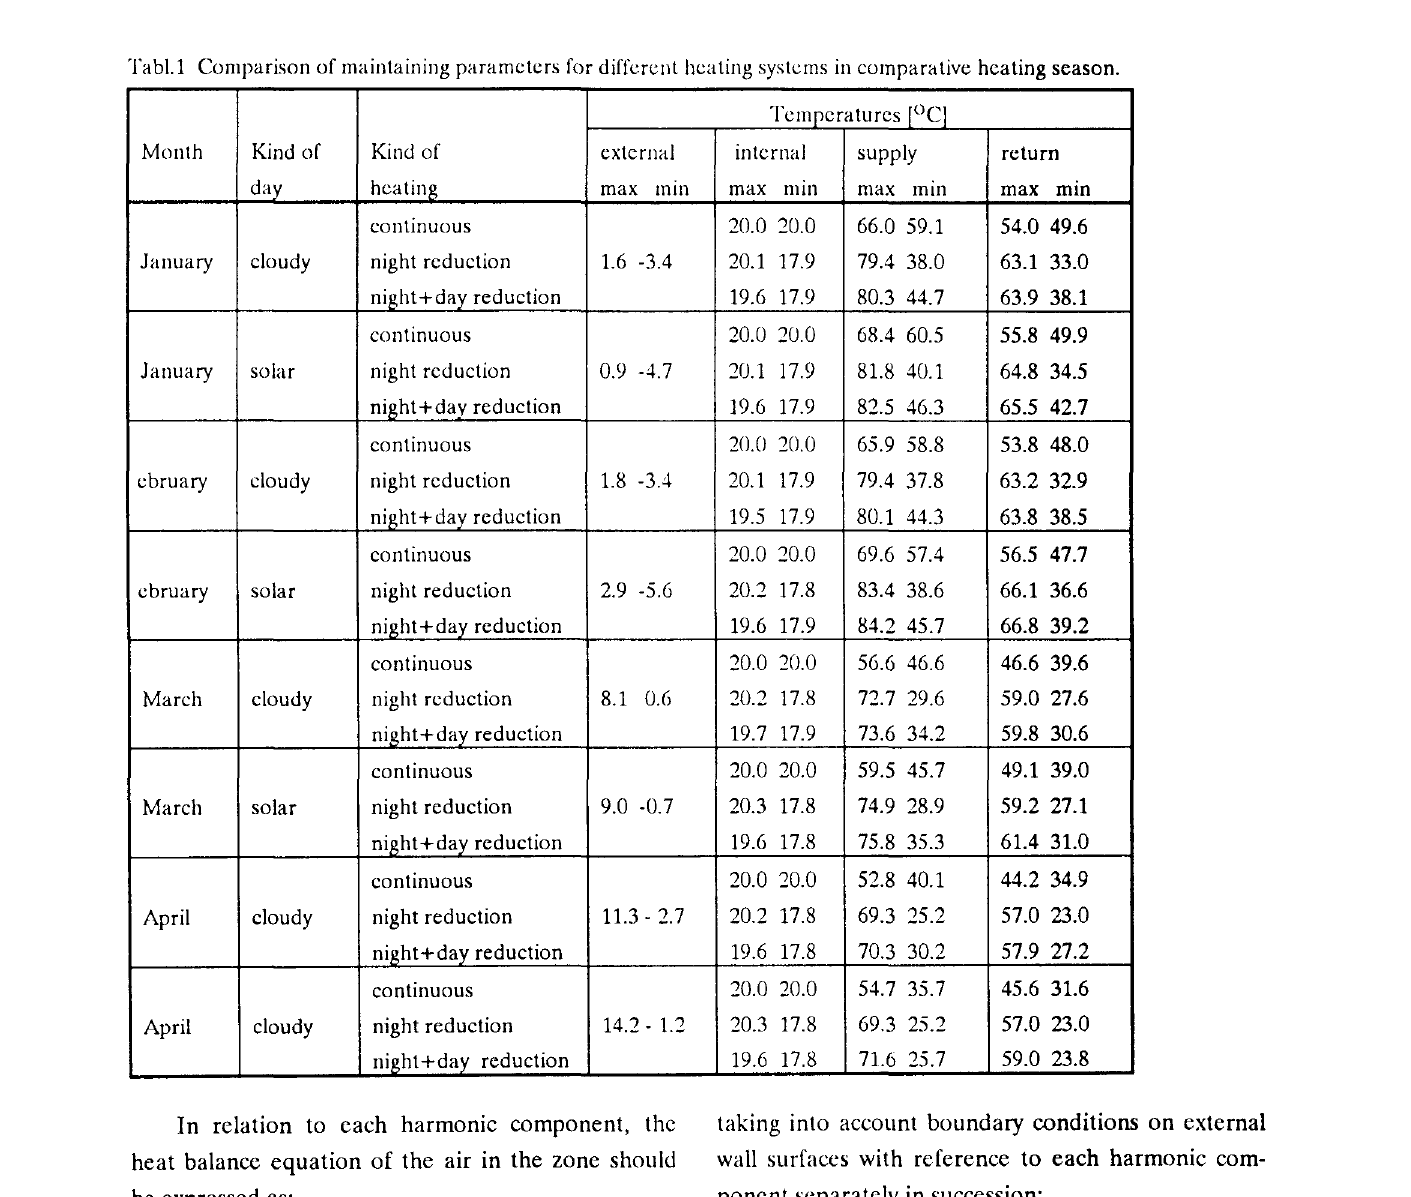
Tabl.1 Comparison of maintaining parameters for different heating systems in comparative heating